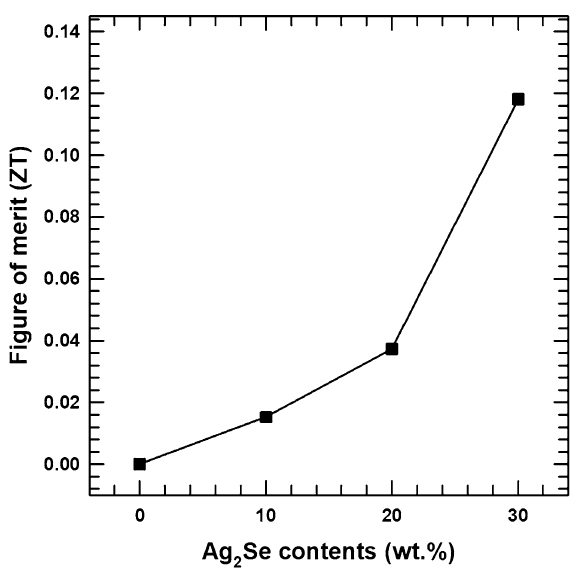
Figure 8. ZT values of composite sample with various AS